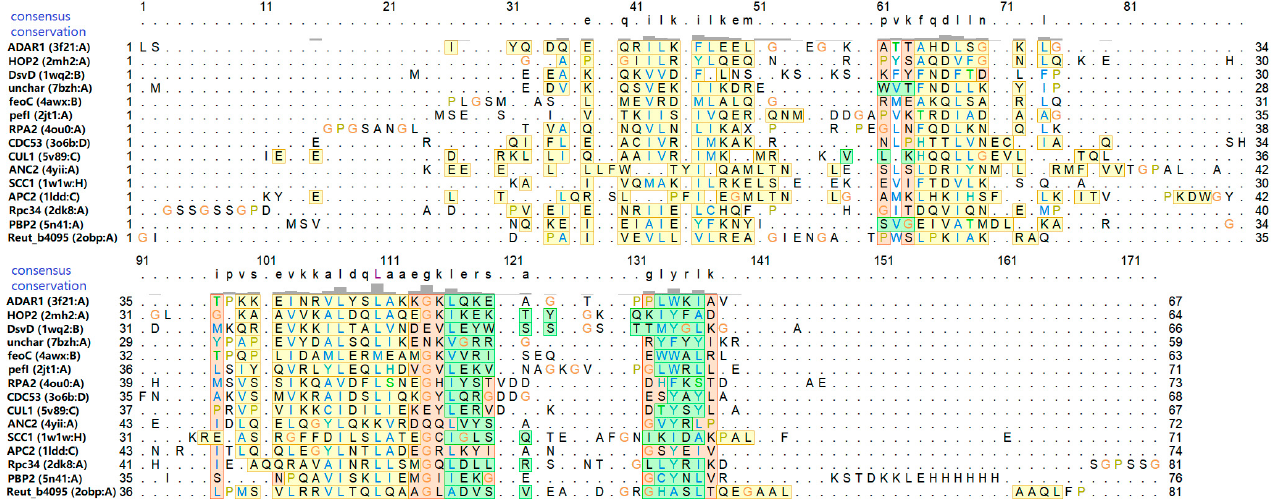
Figure 3. Sequence alignment is constructed from the structural superposition of the Z α domain of human ADAR1 protein (PDB: 3f21) and the 14 possible Z-DNA/Z-RNA binding proteins. The default colour of fully populated columns is light red, in addition, helices are coloured in yellow and strands in green. Letter colours correspond to the ClustalX colouring scheme.